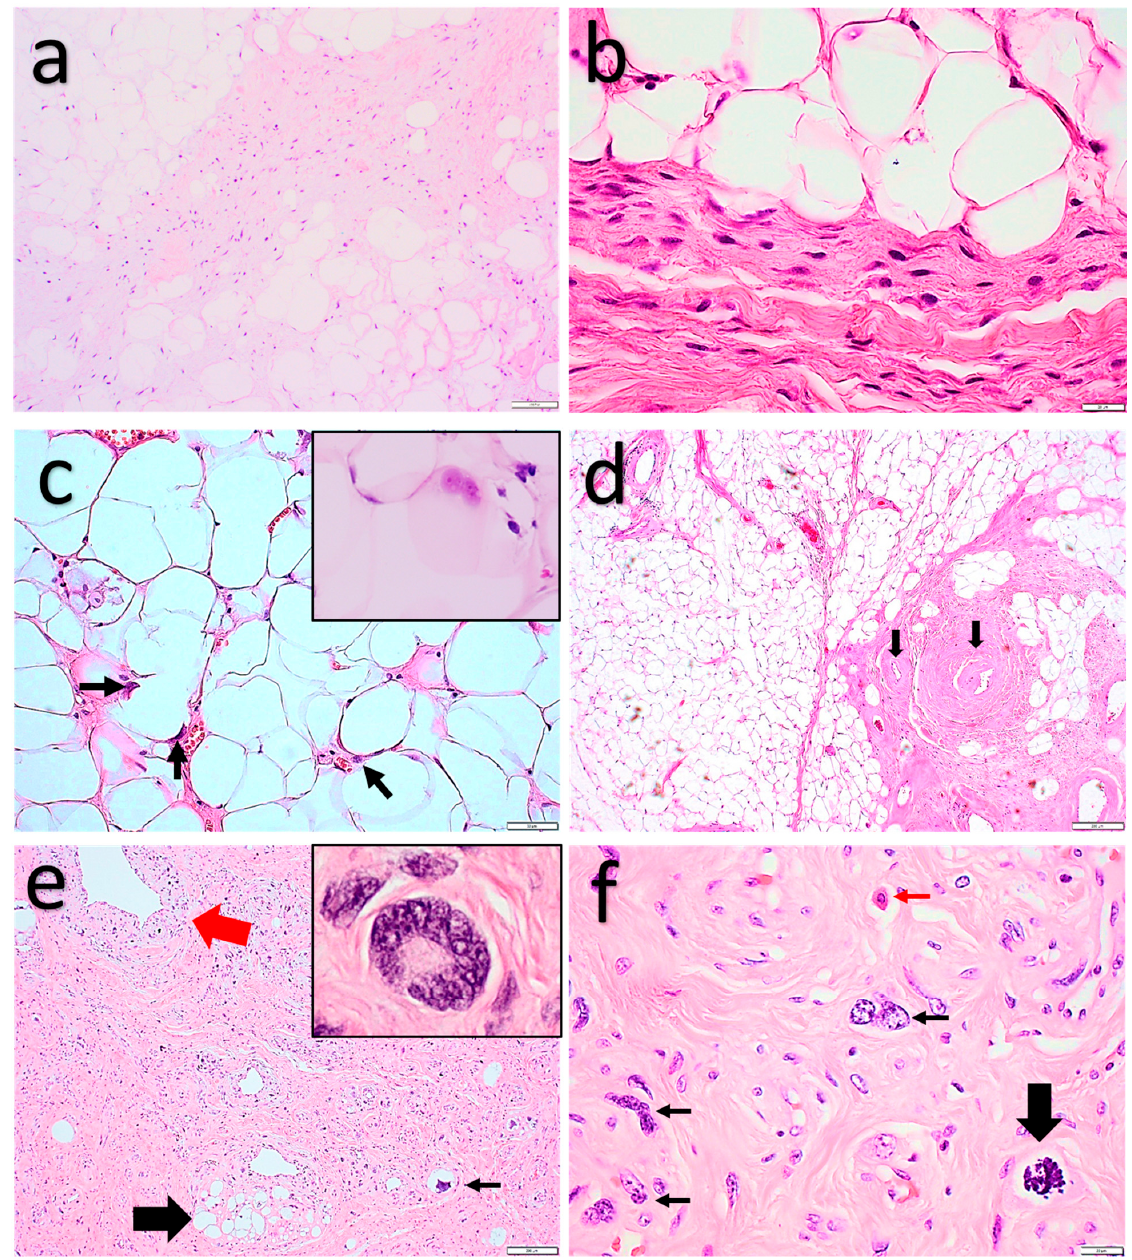
Figure 3. Atypical spindle cell/pleomorphic lipomatous tumor. ( a , b ) Low-cellularity end of the spectrum: mature adipocytes and fibrous septa with slightly increased cellularity. In ( a ), a more myxoid stroma can be seen. (b) Low-cellularity end of the spectrum: spindle cells with mild cytonuclear atypia, adipocytes with some variation in shape and size. (c) Adipocytes with mild cytonuclear atypia (arrows) and binucleation (inset) (adipocytic-rich variant, ‘dysplastic-lipoma’-like morphology). ( d ) Prominent hyalinized vessels. ( e ) High-cellularity end of the spectrum: focal adipocytic component showing adipocytes with variation in size and shape (large black arrow), cellular adipocytic-poor tumor component with perivascular condensation of pleomorphic tumor cells (large red arrow), pleomorphic lipoblasts (small black arrow), and floretlike multinucleated cells (inset). ( f ) High-cellularity end of the spectrum: scattered pleomorphic and multinucleated “bizarre”cells (small black arrows), a mitotic figure (large black arrow), and mast cell (small red arrow).